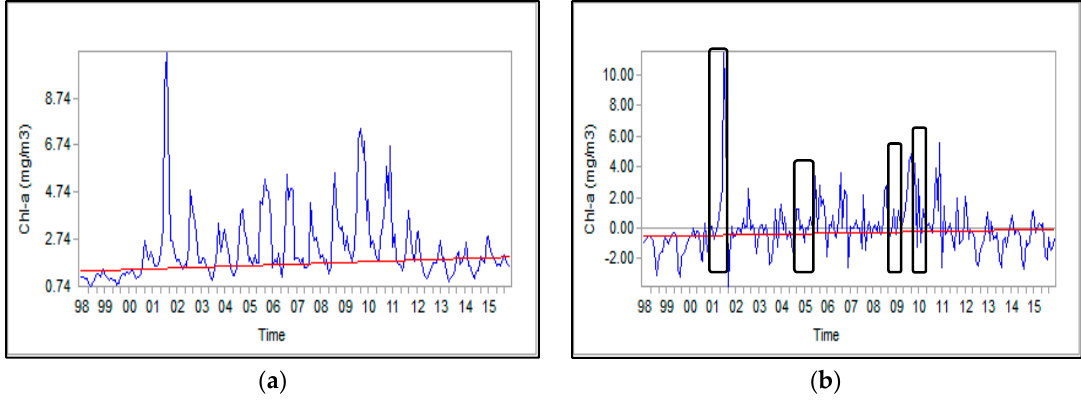
Figure 5. Time series for Chl-a concentration in the SCS: ( a ) absolute values and ( b ) anomalies.